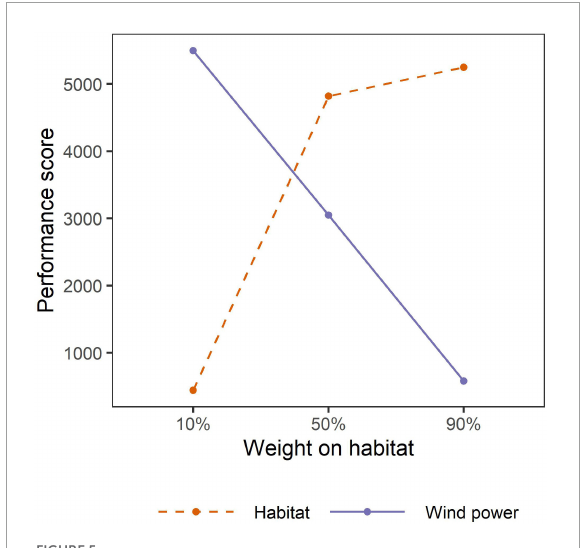
FIGURE5 Sum of weighted performance scores for habitat and wind power values if wind towers were doubled ( n = 13,410) across the U.S. migration corridor under three weighting scenarios. The intersection of the two lines could be considered an indifference point where the tradeoff between wind power and habitat loss is